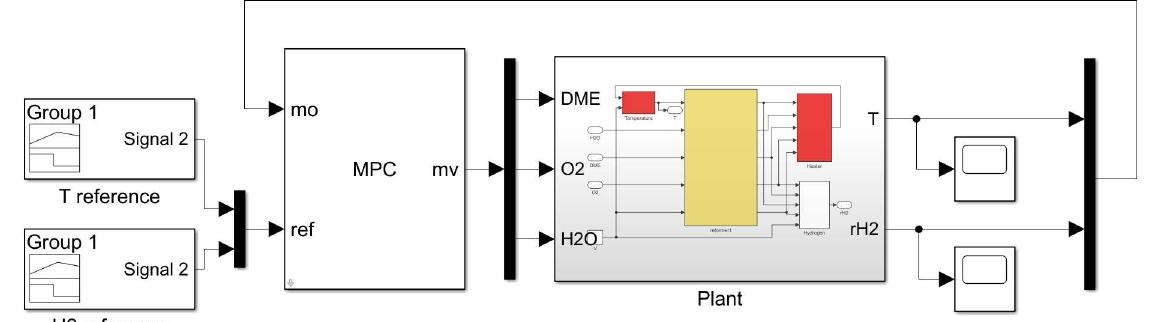
Figure 1. Schematic diagram of the MPC in Simulink.